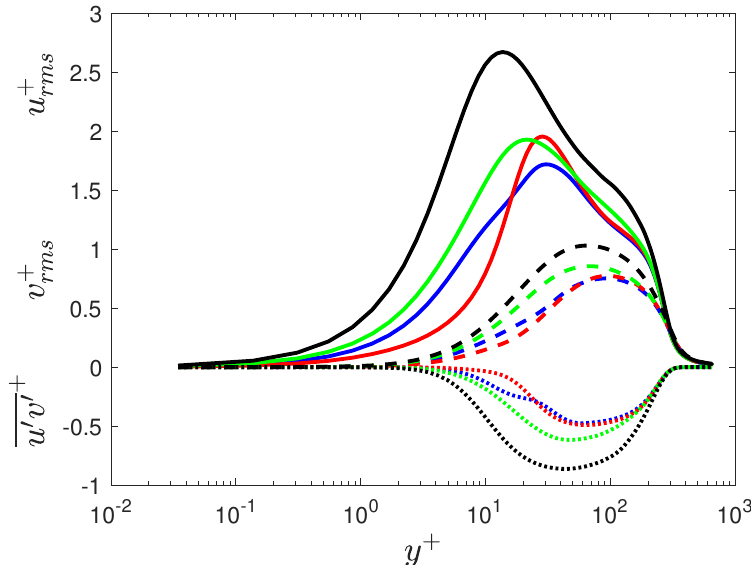
Figure 10. Reynolds stresses for travelling wave case (TW) (red), spatial case (SW) (blue), and temporal case (OW1) (green). Black curves are from the reference case. All profiles are taken from + x = 450. — u + rms ; - - v + rms ; · · · u (cid:48) v (cid:48) . Friction velocity from the reference case at x = 250 (where oscillations start) was used for +